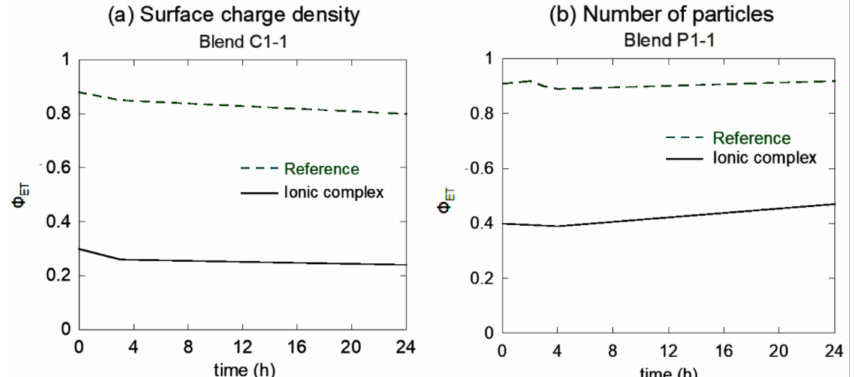
Figure 7. Evolution of quantum efficiency energy transfer during blending of oppositely charged polymer particles blends, performed at different pH for ( a ) Blend C1-1, based on the same surface charge density; and ( b ) Blend P1-1, based on the same number of